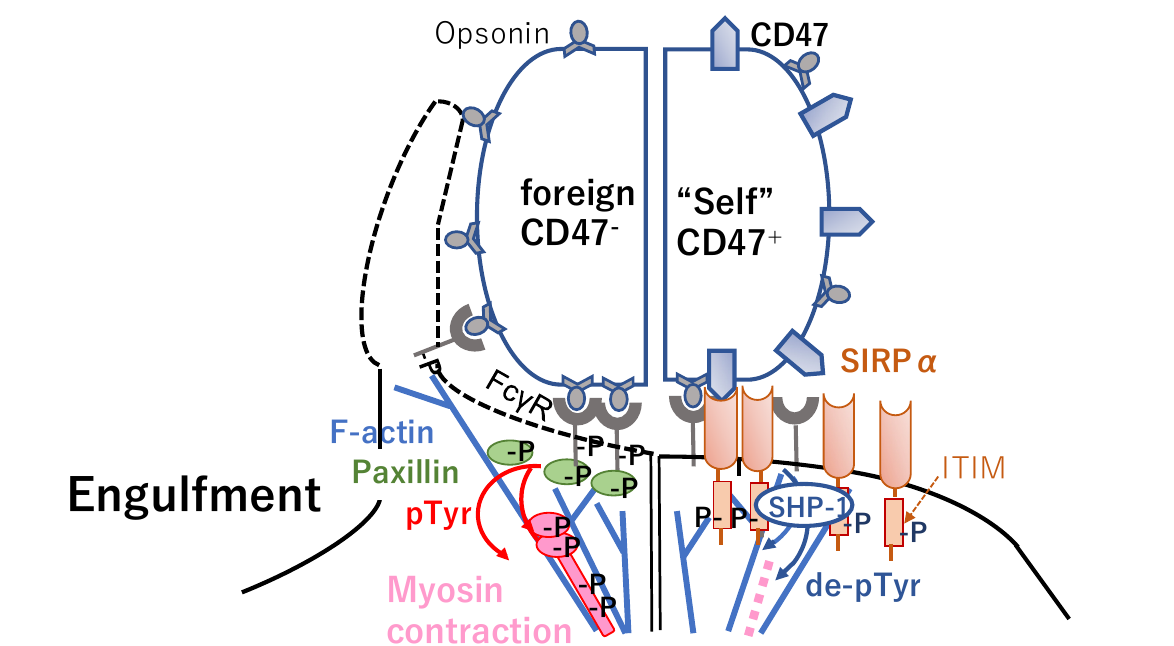
Figure 1. Engagement of CD47 (i.e.,”don’t eat me” signal) on lymphoma cells with SIRP α on macrophages causes activation and phosphorylation of SIRP α ITIM motifs and the recruitment of SHP-1 phosphatases ( right ) preventing myosin-IIA accumulation at the phagocytic synapse ( left ), which results in inhibiting lymphoma cell phagocytosis. IgG activates the Fc γ R receptor on the phagocyte and induces actin cytoskeleton assembly. IgG-opsonized target cells lacking CD47 results in binding Fc γ R, leading to activated assembly of paxillin, F-actin, and non-muscle myosin IIA at the phagocytic synapse ( left ). This F-actin assembly is independent of the signaling pathway of CD47. In contrast, parallel interactions with CD47 signals through SIRP α to inhibit myosin assembly and contraction contribute to efficient phagocytosis (right). α CD47 Abs, antiCD47 antibodies; APCs, antigen-presenting cells; Fc γ R, Fc γ receptor; IgG, immunoglobulin G; ITIM, immunoreceptor tyrosine-based inhibitory motif; MØ, macrophage; MHC, major histocompatibility complex; pTyr, phosphotyrosine; SHP-1, Src-homology 2 domain-containing protein tyrosine phosphatase-1; SIRP α , signal regulatory protein alpha.